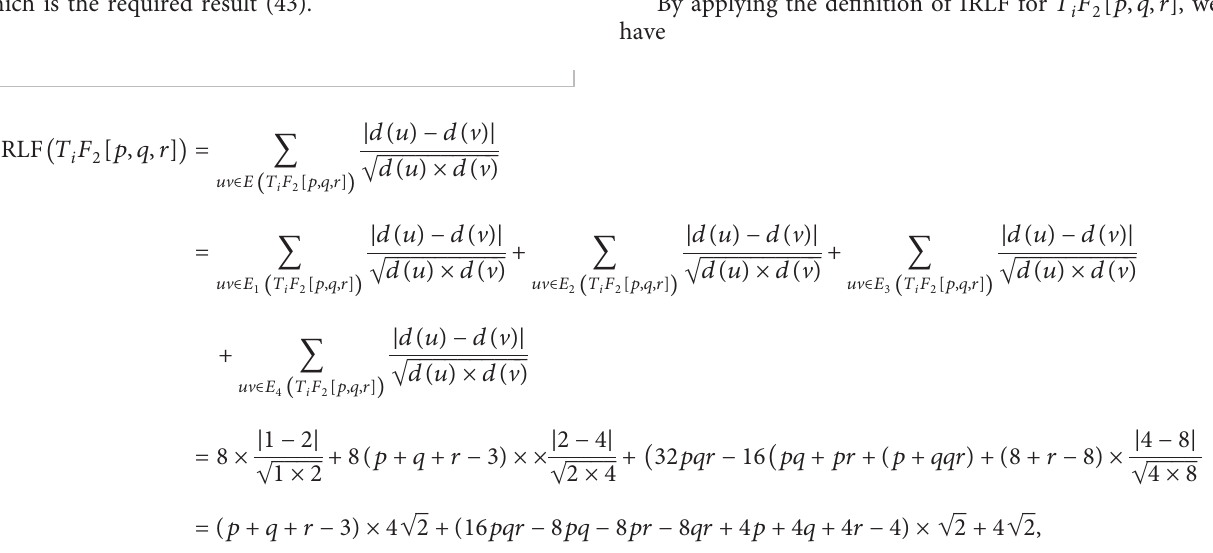
t , and IRF for crystallographic structure Cu 2 O